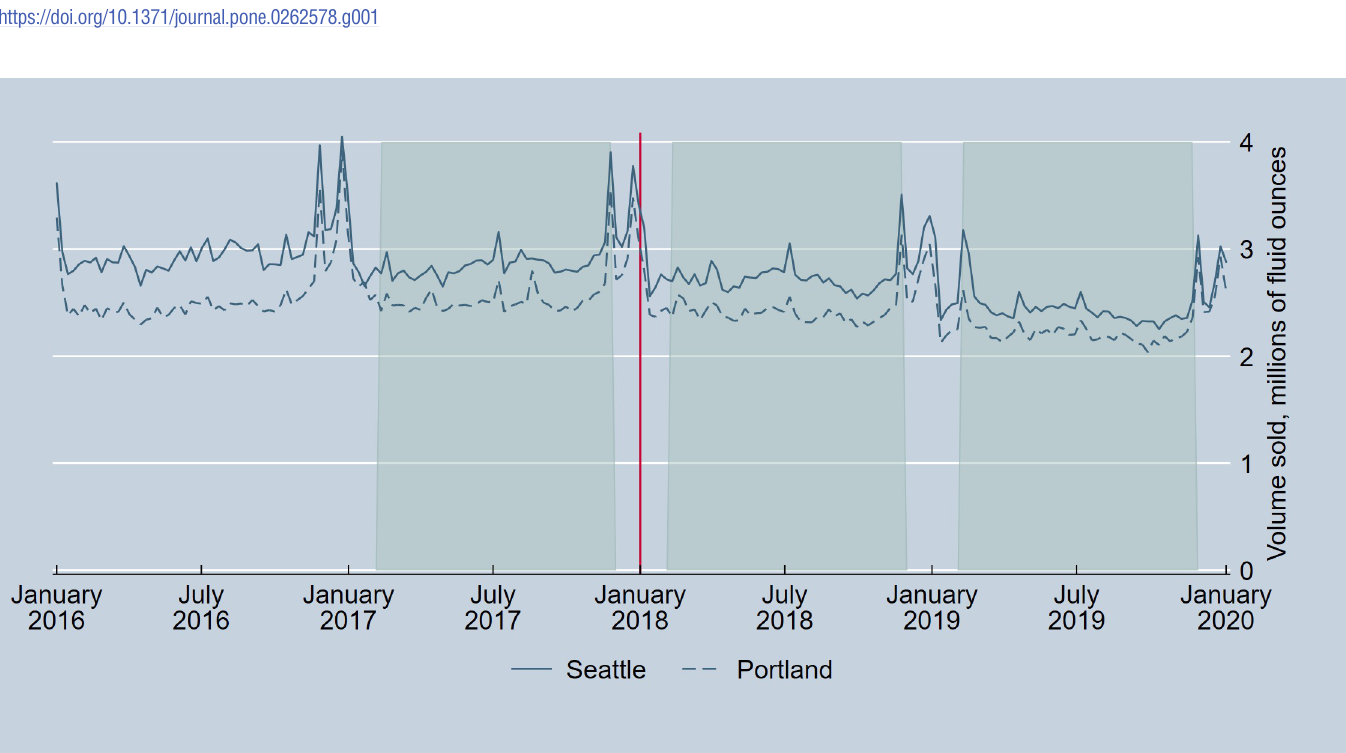
Fig 2. Volume sold of wine in Seattle, Washington, and Portland, Oregon, pre- and post-implementation of the Seattle Sweetened Beverage Tax. The vertical line indicates the date of tax implementation. Shaded regions correspond to the analytical time periods.